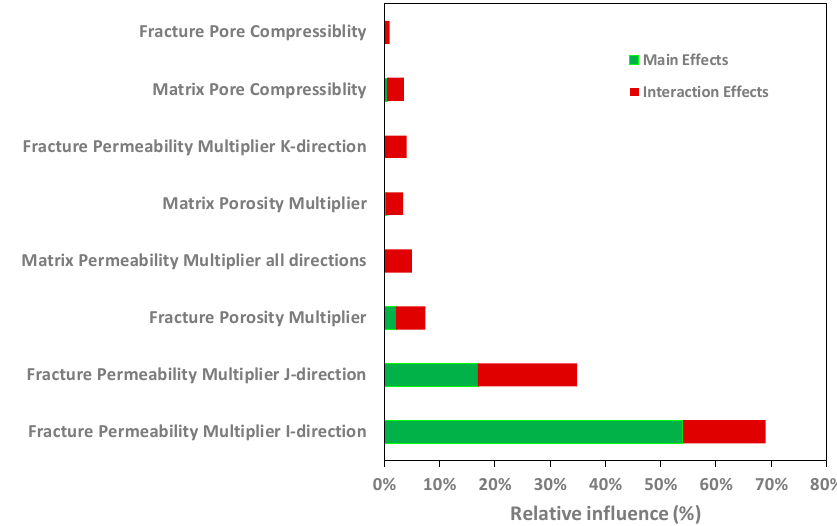
Figure 8. The relative influences of the parameter change on the objective function, GlobalHMError, which characterizes the error between the model and well measurements during the history matching of the single-phase brine injections. The main and interaction effects are respectively linear and quadratic influences of the parameter change on the objective function.